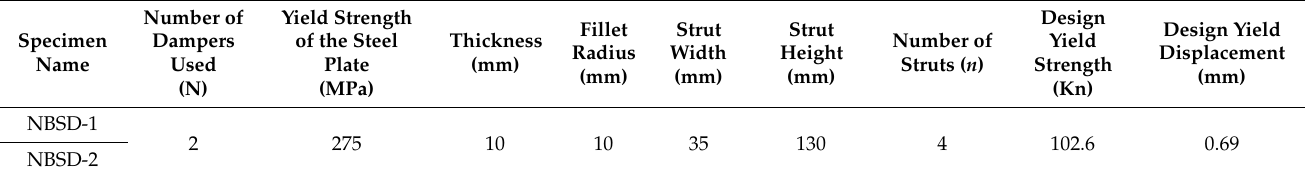
Table 1. NBSD specimens used in the material testing and the corresponding calculation